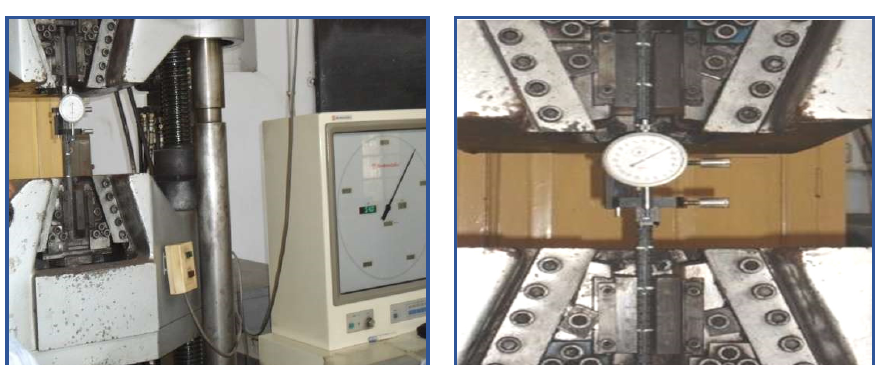
Figure 3. Steel bar tension test in progress using digital UTM (ASTM A ‐ 370 ‐ 03).